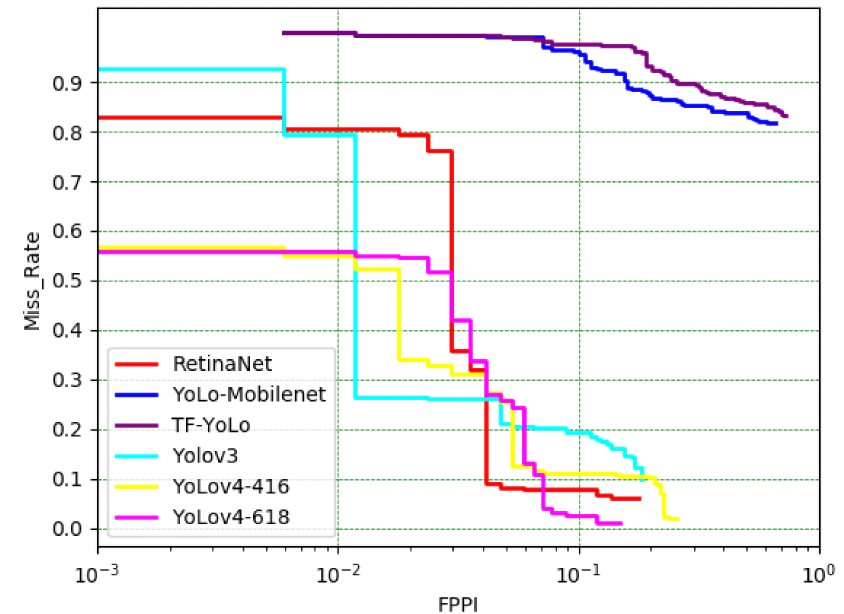
Figure 14. Comparison of miss rate for different deep learning